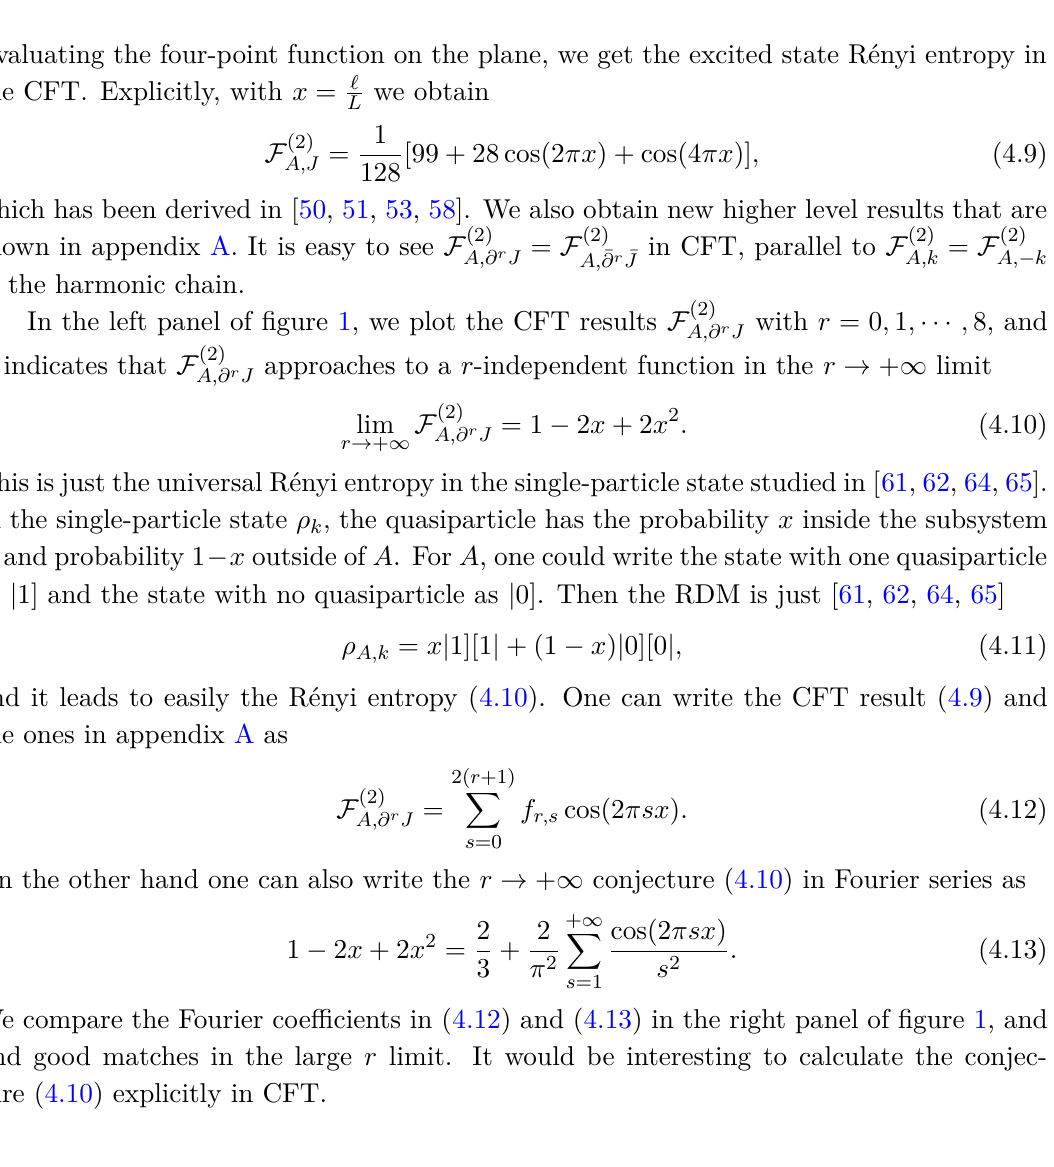
Figure 1 . The single-interval Rényi entropy of the excited sates of the current and its derivatives in the 2D free massless bosonic theory (left) and the coefficients (4.12) in the Fourier expansion (right). The dashed lines in the right panel are the Fourier coefficients (4.13) for the conjectured result at r = + ∞ (4.10). We verify